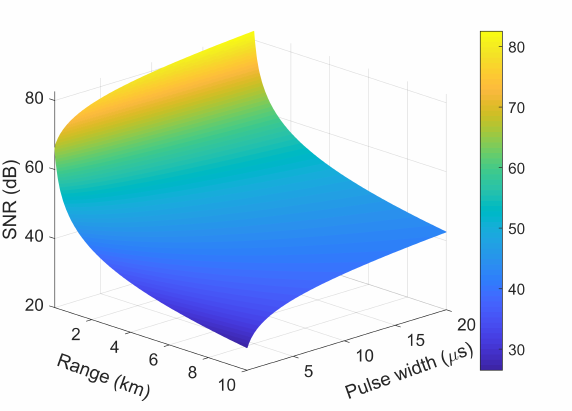
Figure 2. The geometry of BiSAR system. The synchronization signals are transmitted and received by two synchronization antennas. The radar signal is transmitted by SAR antenna of primary satellite. The echoes of targets are received by two SAR antennas of primary satellite and slave satellite.